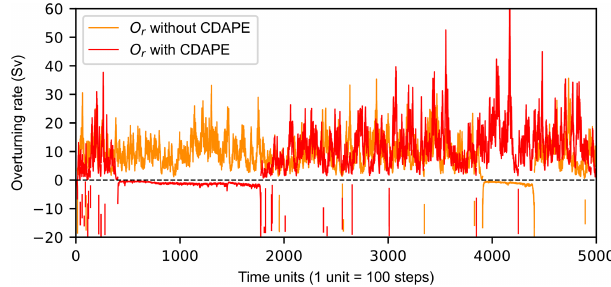
Figure 6. Time series of the estimated κ values with a Gaussian perturbation that has a mean value of 32 and a standard deviation of 0.1 in the individual ensemble members (orange) in the free model control ensemble simulations with data assimilation and parame- ter estimation. The solid red line denoting κ = 28 marks the true value of κ being estimated. The dotted-dashed black line denoting the 300th unit marks the start of parameter estimation using x 2 , w , and η observations.